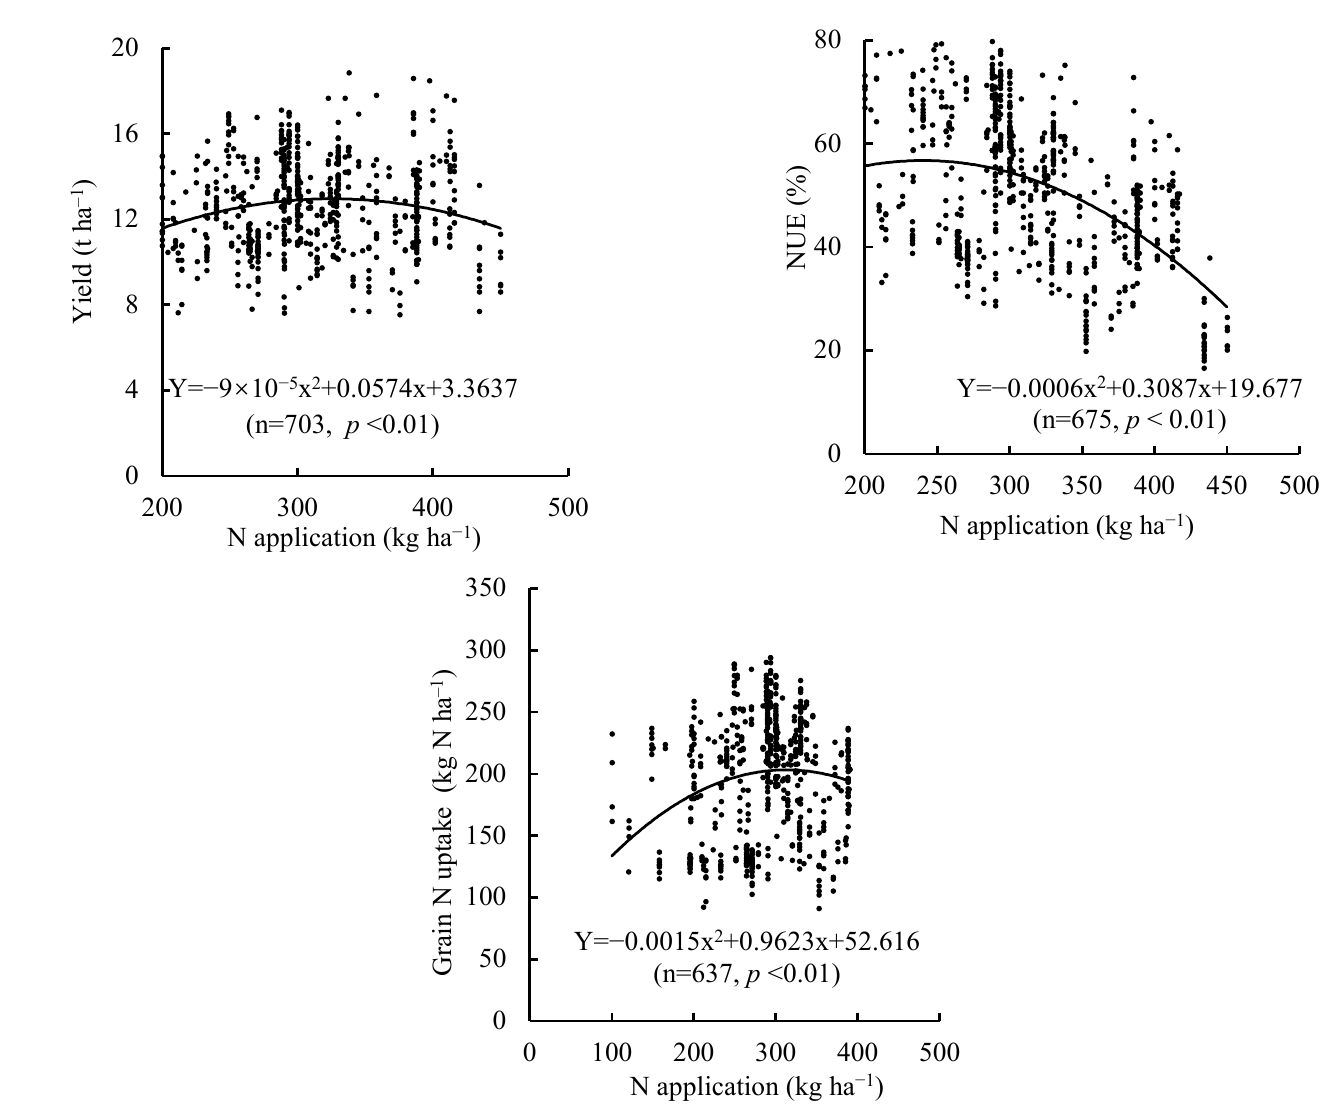
Figure 3. Relationship between N application and yield, NUE, and grain N uptake.